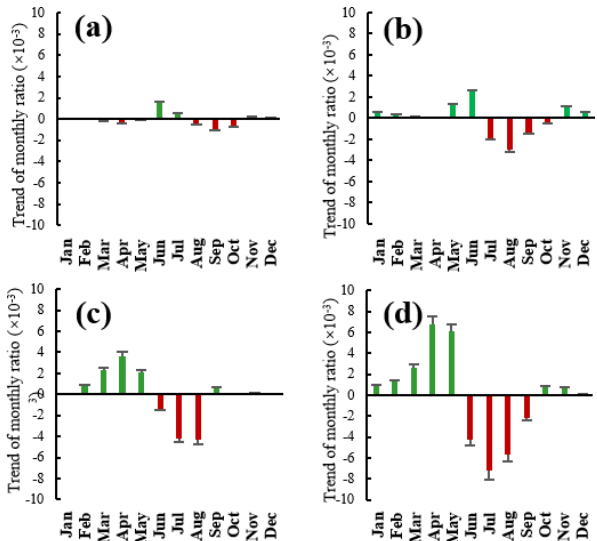
Figure 6. Trends in the ratio of the observed monthly to annual mean LAI of subregions in the (a) source region, (b) TNH–TDG, (c) TDG–LM, (d) LM–HYK. The error bars represent the